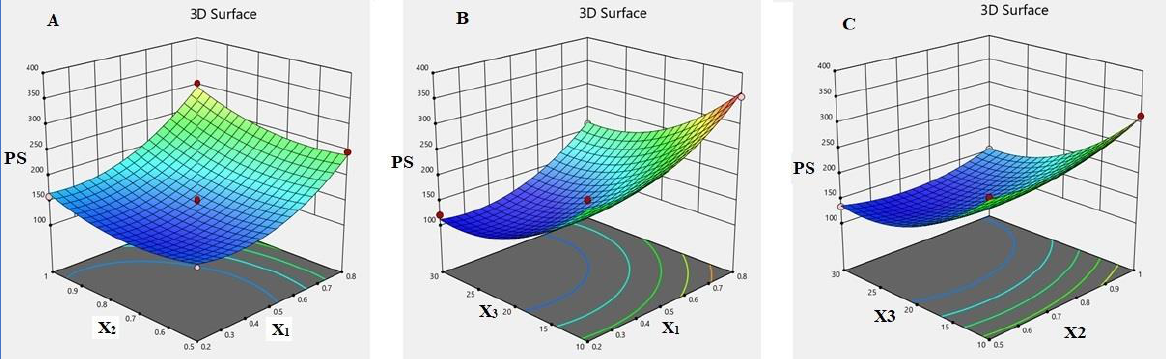
Figure 1. Three-dimensional response surface plot showing the effect of independent variables ( A ) X 1 and X 2 ; ( B ) X 1 and X 3 ; and ( C ) X 2 and X 3 on PS. ( A ) X 1 and X 2 ; ( B ) X 1 and X 3 ; and ( C ) X 2 and X 3 on